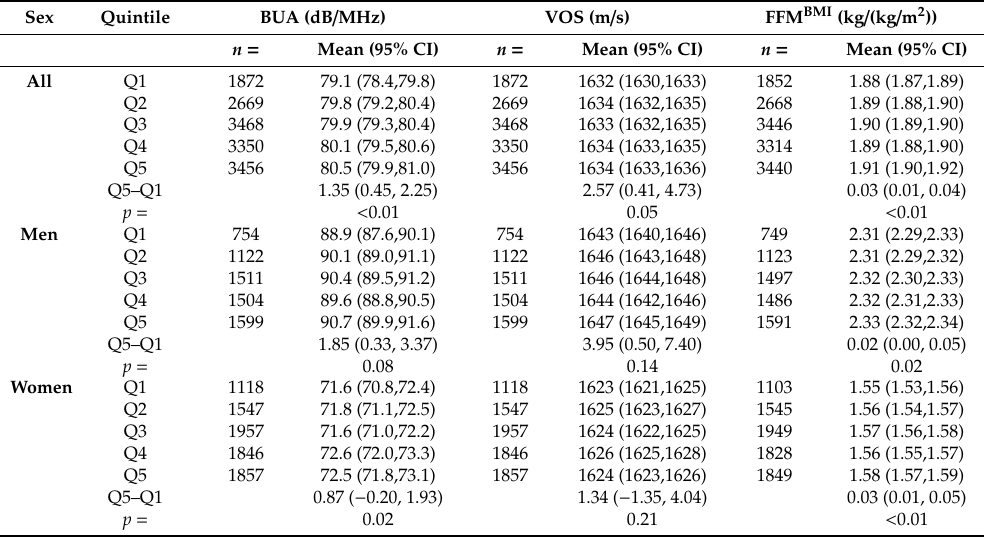
(corticosteroids, aspirin or hormone replacement therapy), menopausal status, days of dietary intake data and the ratio of energy intake to estimated energy requirements. BMI was not included in the FFM BMI model. p values are for trends calculated using ANCOVA. Range of aMED in each quintile was Q1 = 0 to 2 points, Q2 = 3 points. Q3 = 4 points, Q4 = 5 points, Q5 = 6 to 9 points. BUA = broadband ultrasound attenuation; VOS = velocity of sound; FFM BMI = fat free mass adjusted for BMI. Table 4. Measures of broadband ultrasound attenuation, velocity of sound and fat free mass by quintile of Mediterranean Diet Score in 14,815 men and women aged 42–82 years, stratified by sex